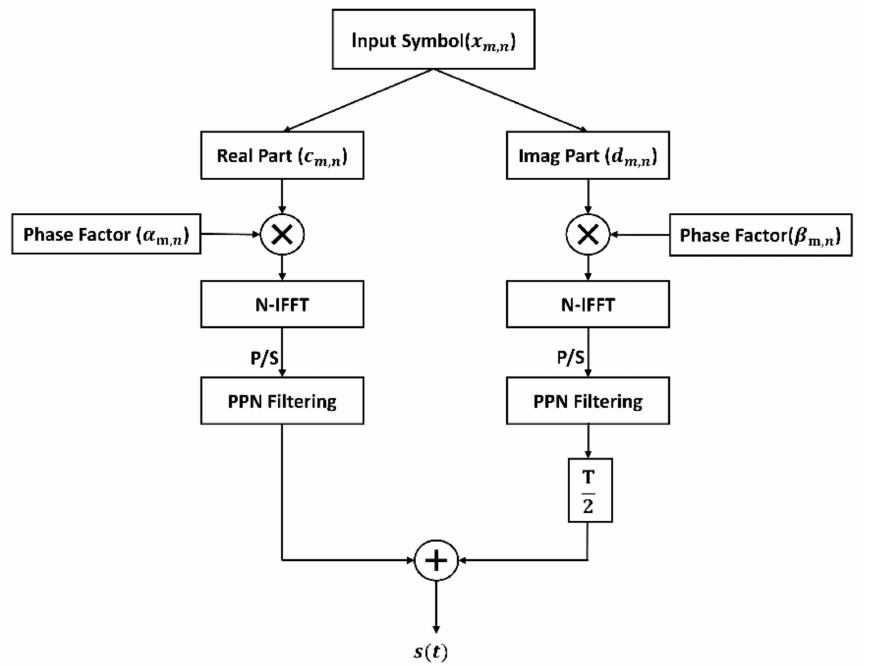
Figure 1. Transmitter structure of FBMC/OQAM (filter bank multicarrier with offset quadrature amplitude modulation).